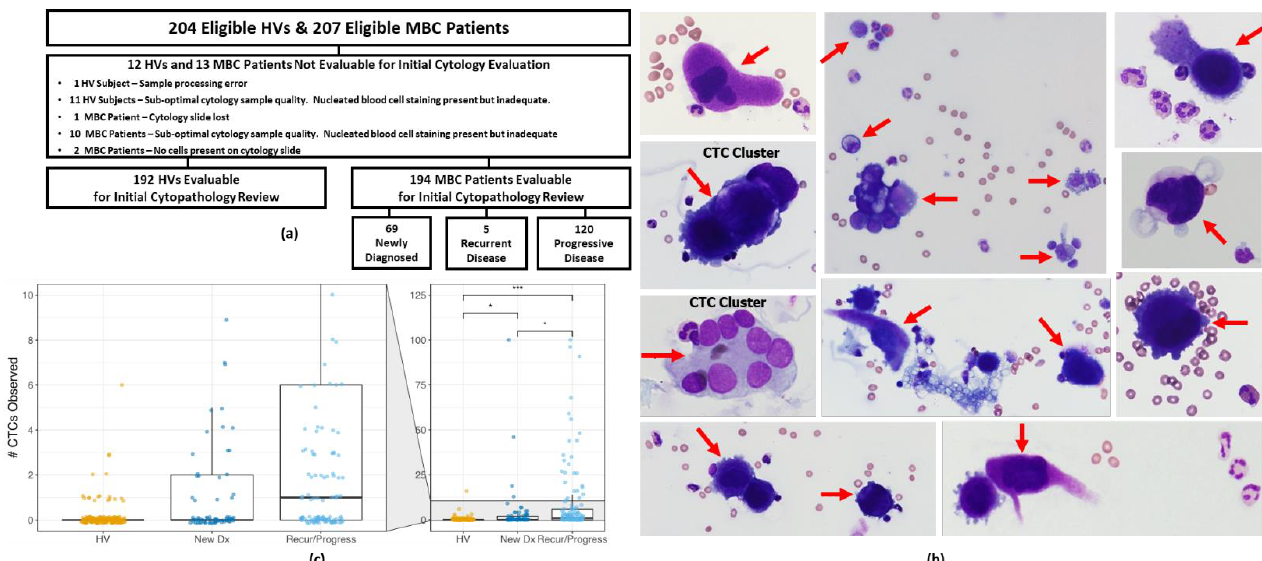
Figure 2. ( a ) Flow diagram for cytopathology evaluation in 207 eligible MBC patients. ( b ) Representative images of cells classified as CTCs (red arrows) from MBC patients that were harvested by the Parsortix PC1 system and deposited onto cytology slides by cytocentrifugation (images not to same scale) and Wright-Giemsa stained. ( c ) CTC numbers from the review of evaluable Wright-Giemsa-stained cytology slides. CTC, circulating tumor cell; HV, healthy volunteer; MBC, metastatic breast cancer. * p < 0.05, *** p < 0.001. Table 3. Summary of CTCs from review of evaluable Wright-Giemsa stained cytology slides from 192 HV subjects and 194 MBC patients.